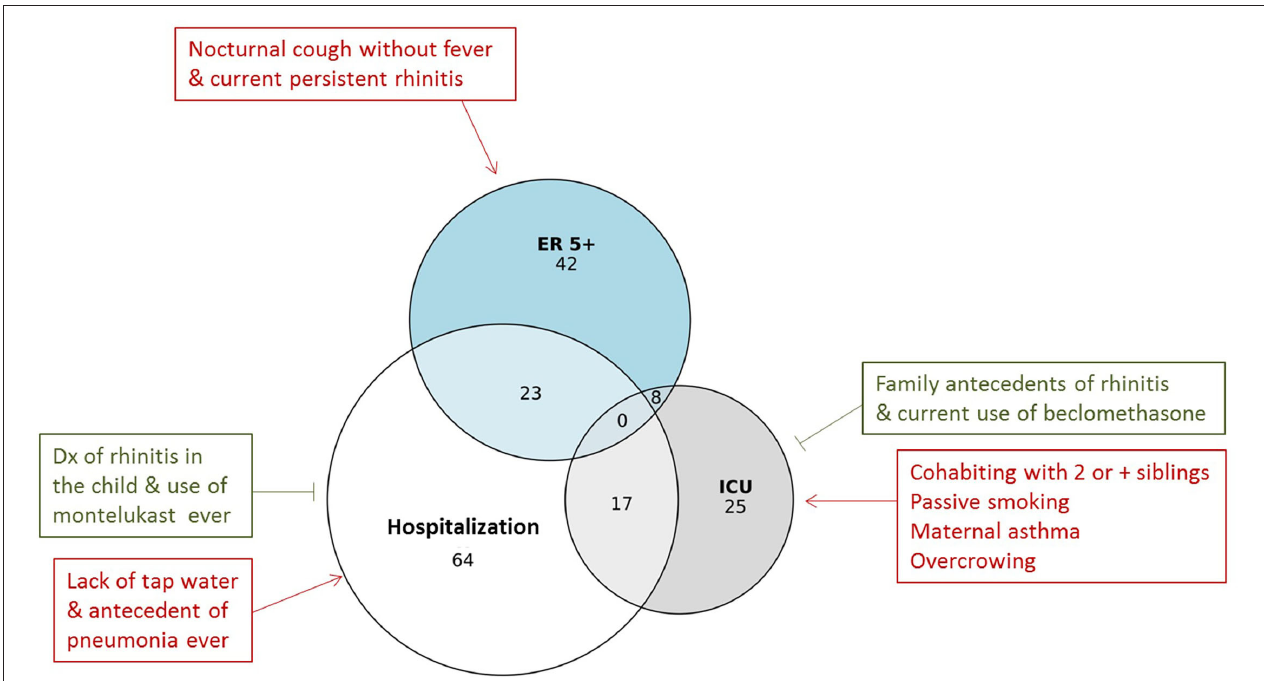
FIGURE 5 | Euler diagram for the overlap among children having had more than 5 ER visits due to wheezing (ER 5 + ) with those that had been hospitalized and/or admitted to the ICU due to wheezing ( n = 127). Number of subjects is indicated in the circles. The risk factors and exposures associated to health care utilization are presented within boxes. Red indicates increased risk and green decreased